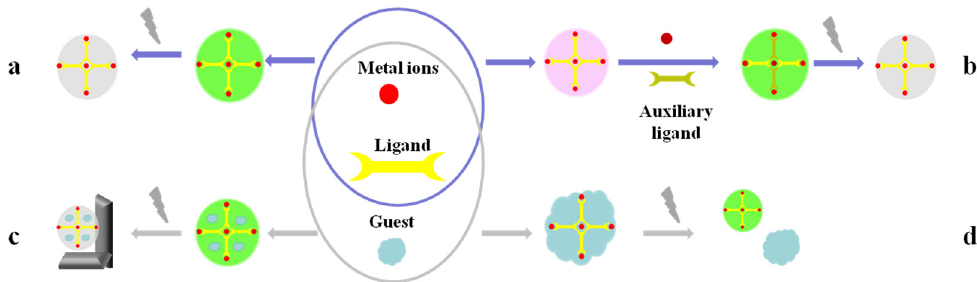
Figure 1. Four different sensing mechanisms of metal-organic framework (MOF)-based stimuli-responsive polymer (SRP) sensors. ( a ) Direct sensing approach with metal ions and ligand assemblies. ( b ) Auxiliary ligands or metal ions aided sensing approach. ( c ) Guest molecules involved sensing approach with improved selectivity. ( d ) Guest molecules involved sensing approach with dual response signal. Adapted from reference [16]. Copyright 2017,